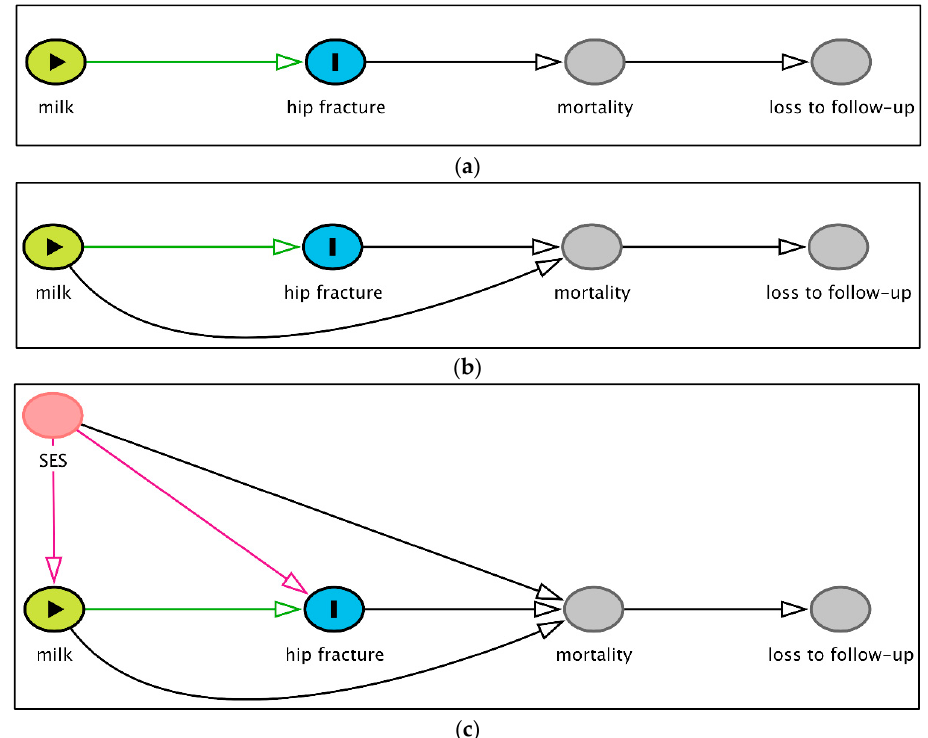
Figure 2. Causal diagrams indicating the assumed causal effects and illustrating the potential collider bias (Berkson’s bias) if hip fractures are ascertained by self-reporting. Since mortality is high following a hip fracture, not all hip fractures may be captured by self-reporting. Conditioning on a collider (here: mortality or, rather, survivors) or a descendant of a collider (here: loss to follow-up or hip fracture ascertainment) may induce a special form of collider bias, Berkson’s bias, known to bias associations between the exposure (milk intake) and outcome (hip fracture), so that a positive association is moved towards a null association, and if the bias is stronger than the association or if no association exists, it may even induce an inverse association. ( a ) Milk intake a ff ects the risk of hip fracture, which, in turn, influences the risk of mortality and, thereby, also the probability of the hip fracture being reported by self-reporting (loss to follow-up). ( b ) Assuming the milk intake a ff ects the risk of both hip fracture and mortality. ( c ) Assuming the socioeconomic status (SES) a ff ects the milk intake, hip fracture, and mortality. The causal diagrams were constructed using DAGitty.net